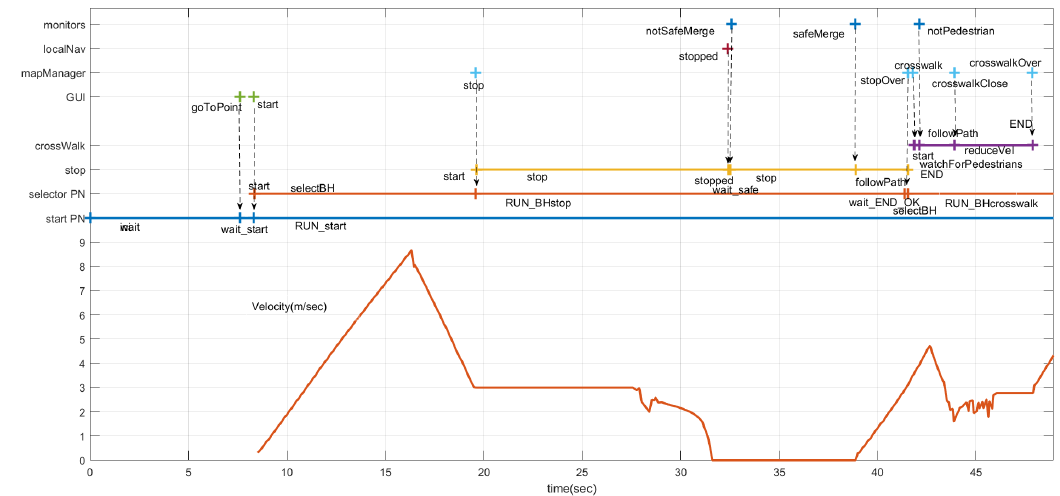
Figure 14. Temporal diagram. At the top, the events produced by modules monitors, localNav, mapManager, and GUI. In the middle, the evolution of crossWalk, stop, selector, and start PNs. At the bottom, the velocity commanded to the